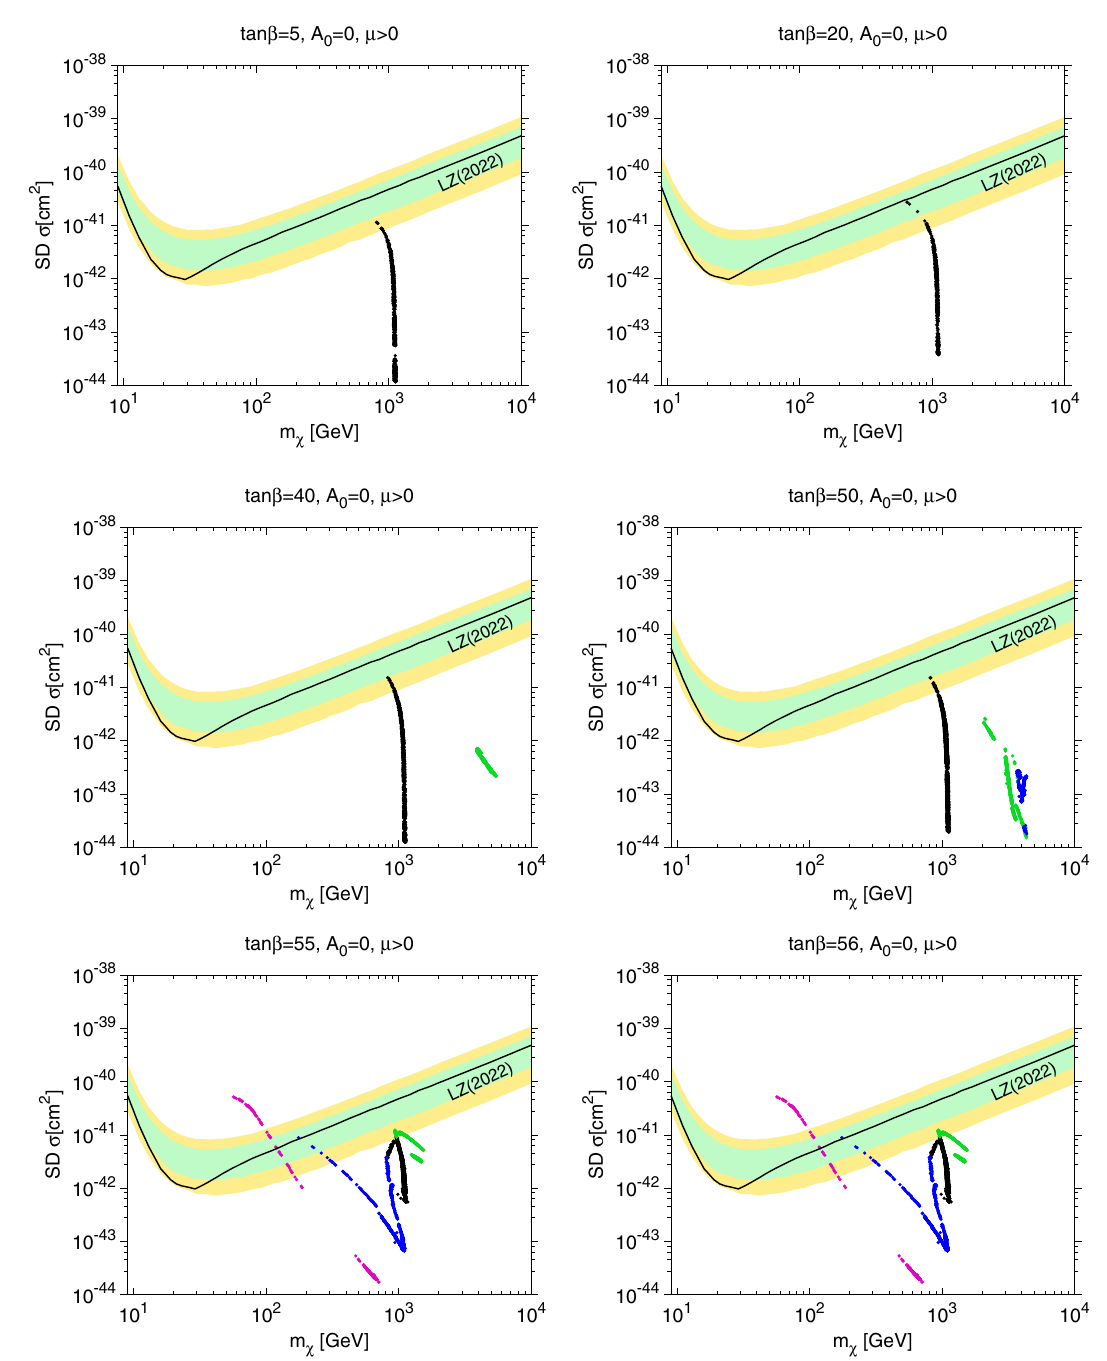
Fig. 10 Calculations of spin-dependent WIMP-nucleon scattering for points along the dark matter strips for tan β = 5 , 20 , 40 , 50 , 55 and 56 with A 0 = 0 and μ > 0 compared with the LUX-ZEPLIN upper limit